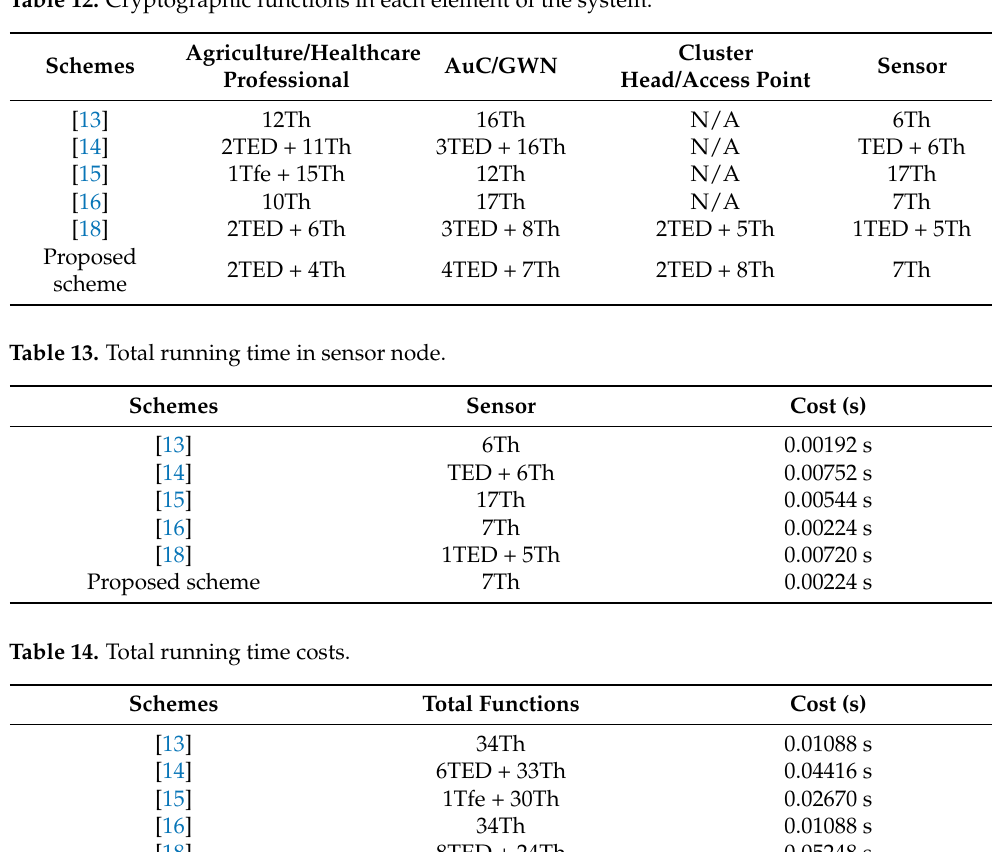
Table 12. Cryptographic functions in each element of the system.